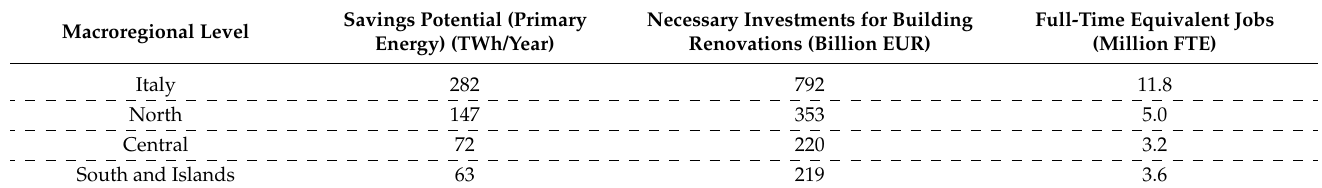
Table 8. Technical savings potential (primary energy), investment needs and FTE jobs associated with the renovation of the Italian residential building